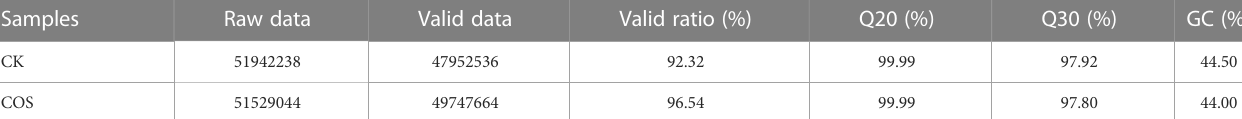
TABLE 3 The summary quality statistics results of the transcriptome sequencing data. Samples